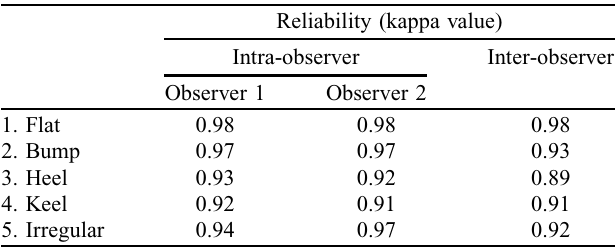
Table 2. Describes the reliability of arthroscopic morphological classification of the acromial spur.